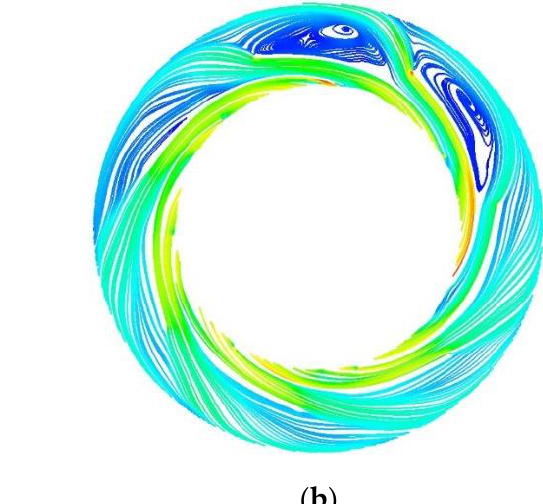
Figure 13. Efficiency and head comparison of the original and modified guide vane structures. ( a ) Efficiency comparison; ( b ) head comparison.